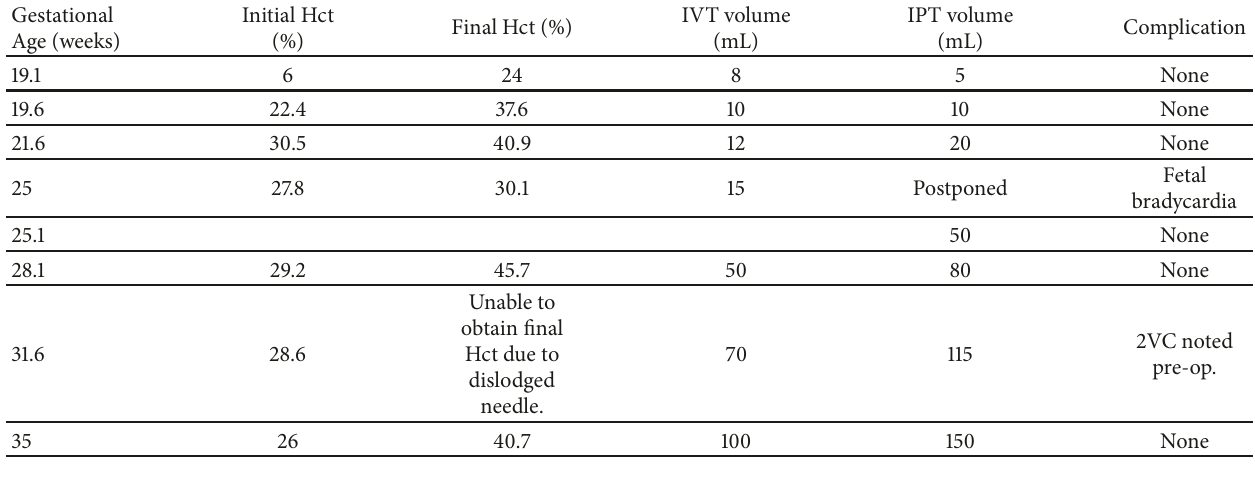
Table 1: Intraoperative fetal transfusion data.